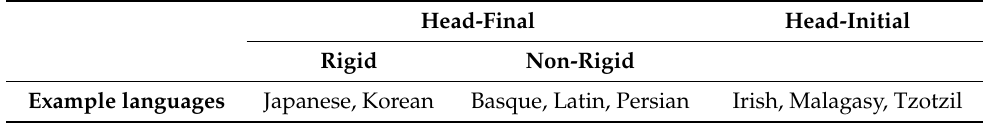
Table 1. Basic headedness types used in this